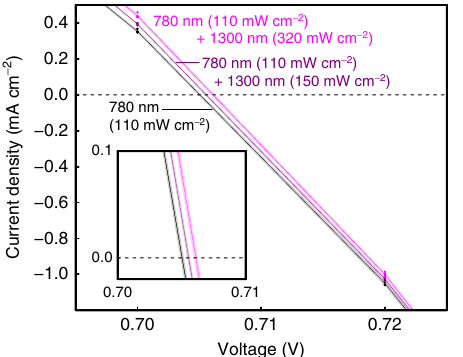
Fig. 3 Current – voltage curve under the two-colour illumination of 780 nm and 1300 nm lasers: the solid circles indicate data points at 0.70 V and 0.72 V. The shaded areas represent the width of the standard error evaluated using the data. The inset shows the magni fi cation of the open- circuit voltage curve as indicated in the inset of Fig. 7a of the original article. All data are the same as the data in the Fig. 7a, b, and c of the